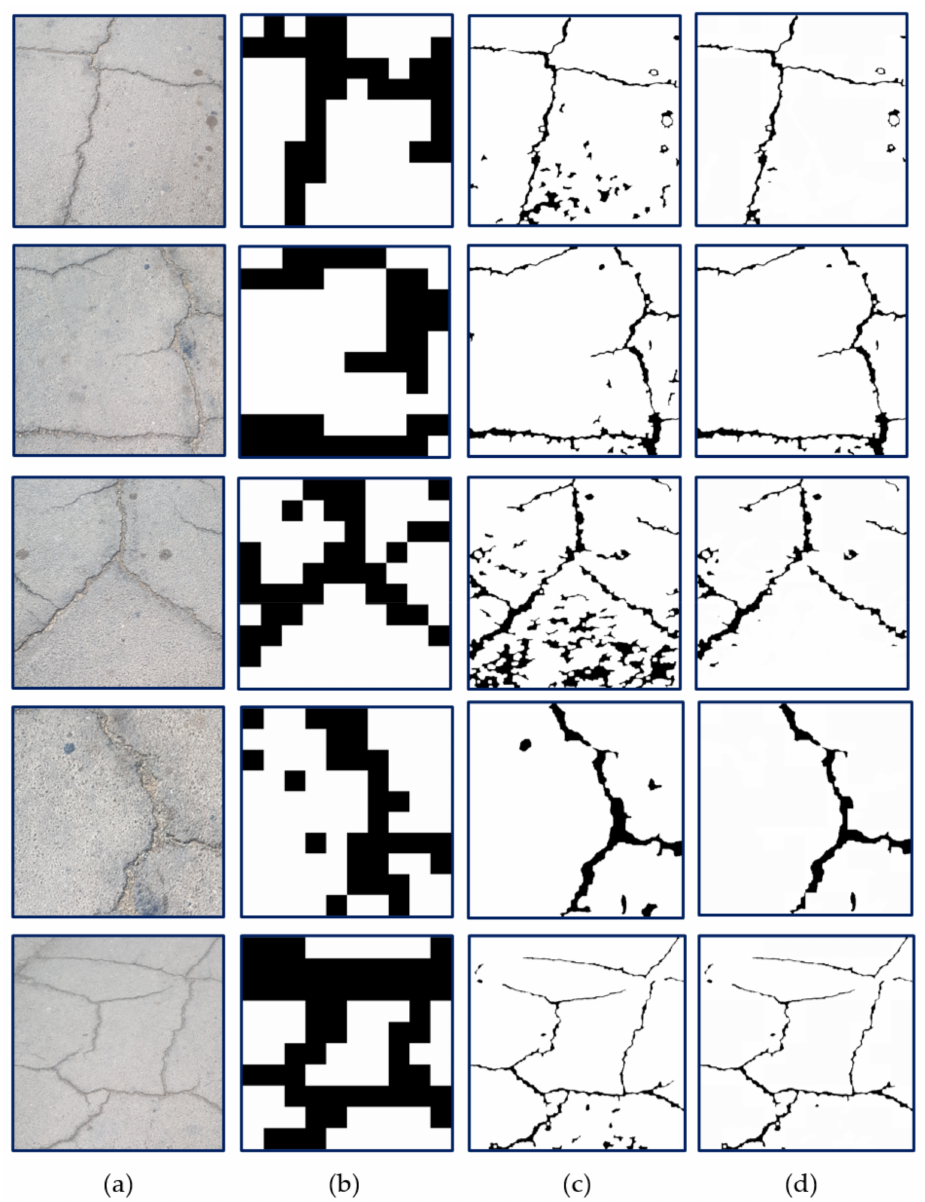
Figure 10. ( a ) Original images; ( b ) localization-mapping result from sliding window-based vision- transformer; ( c ) mapping results from TuFF; ( d ) integration of results from sliding-window-based ViT and the TuFF